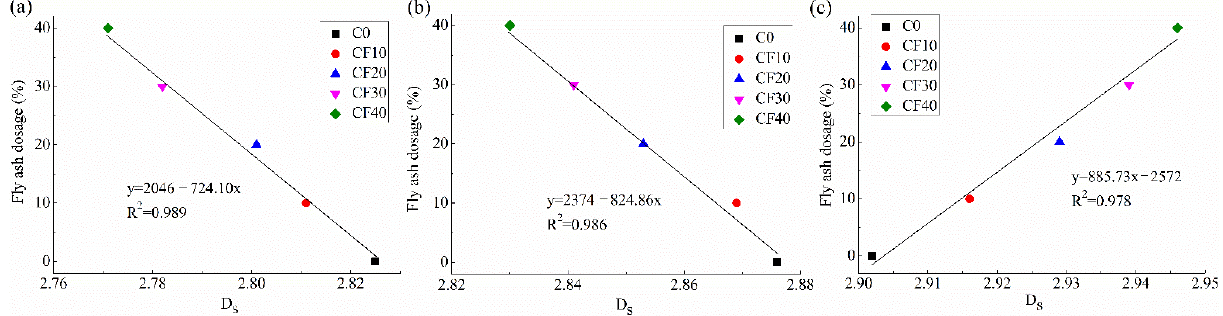
Figure 8. Correlations between D s and fly ash dosage at ( a ) 3 days, ( b ) 28 days and ( c ) 180 days.